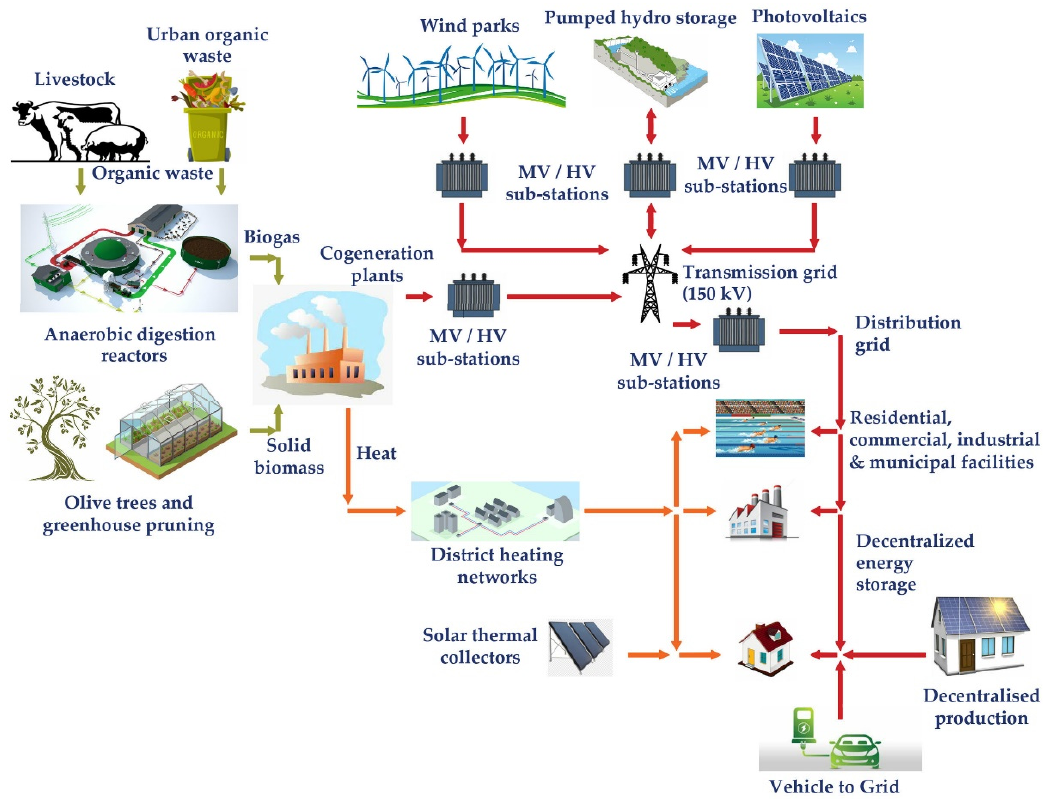
Figure 9. Overall energy transition concept in Crete.